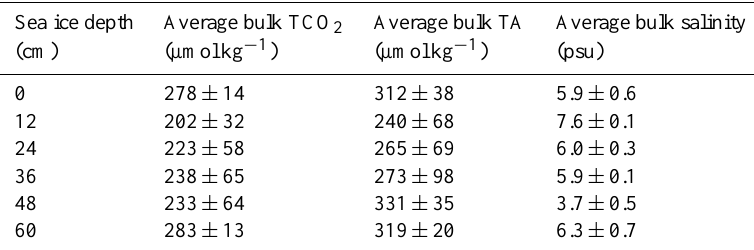
Fig. 4. Measured CO 2 , and heat fluxes ( Q ) over the ice. The heat flux is measured using the eddy covariance (EC) technique and the CO 2 flux is estimated from EC technique, the cospectra peak method and the dissipation method. The dot shows the mean of the three methods and the bar shows the standard deviation. Table 1. Average concentrations of bulk TCO 2 and TA and average sea ice bulk salinity. Data points represent data from 3 sampling days from the March 10 to 15,